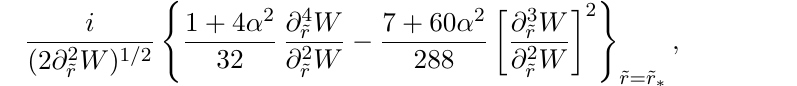
= r ( ‘ ) (cid:0) r (3). This shows that the location r ‘; 3 ; GR ; GR (cid:3) (cid:3)